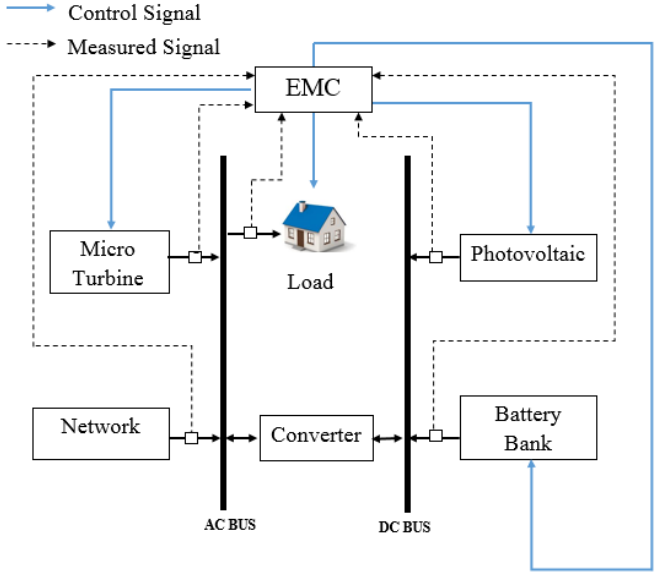
Fig. 1. Structure of EMC and hybrid energy